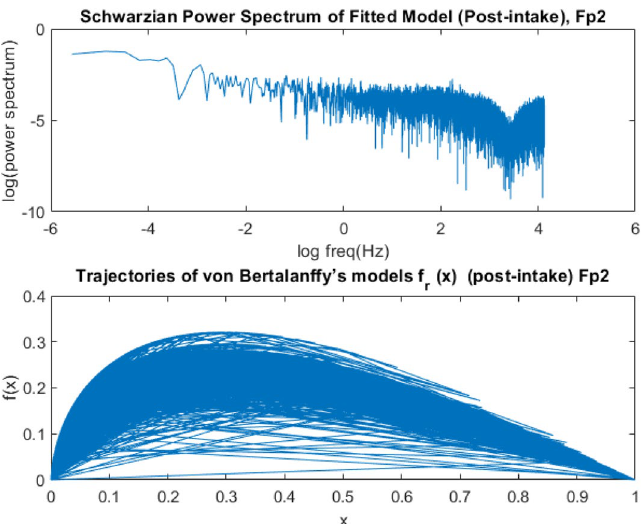
Figure 12. Power Spectrogram of Schwarzian and von Bertalanffy’s EEG Phase Growth Model after medication for Fp2 electrode for an interval of 30,000-time points of T = 500 time points for each segment at fs = 125